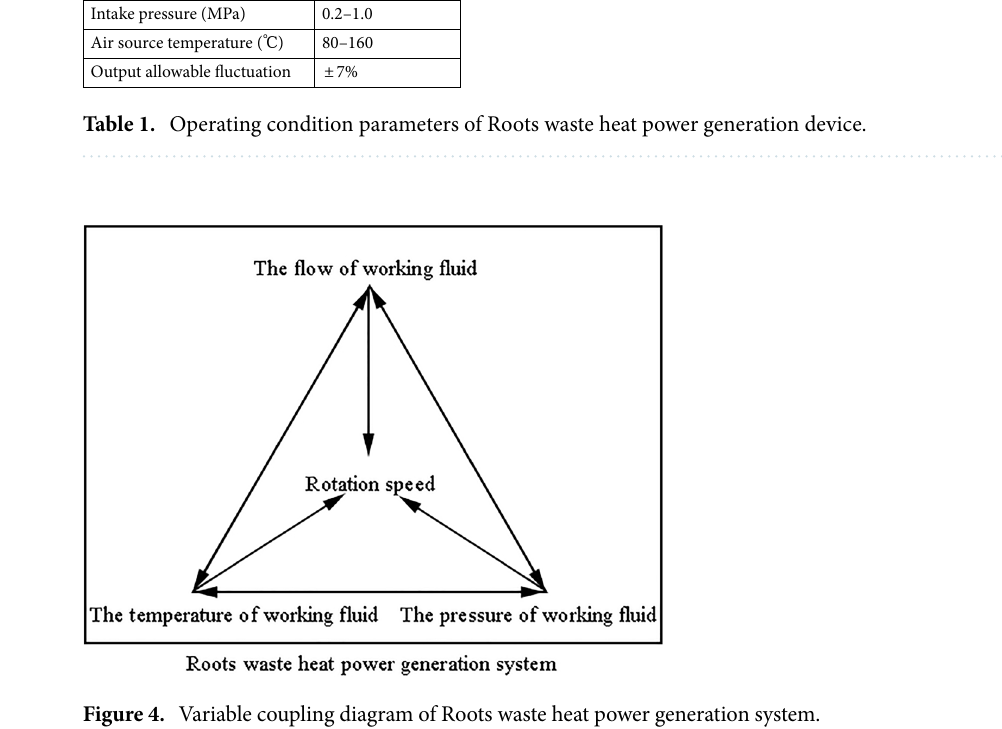
Figure 4. Variable coupling diagram of Roots waste heat power generation